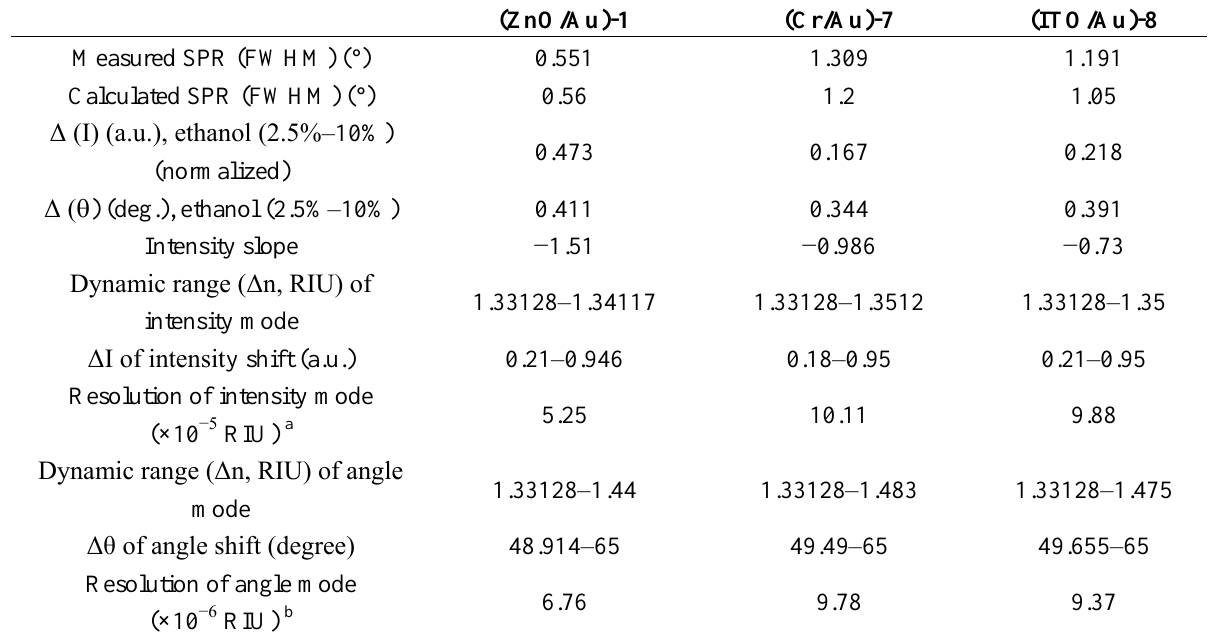
Table 3. Performance comparisons of (ZnO/Au)-1, (Cr/Au)-7, and (ITO/Au)-8 devices. (ZnO/Au)-1 (Cr/Au)-7 (ITO/Au)-8 Measured SPR (FWHM)